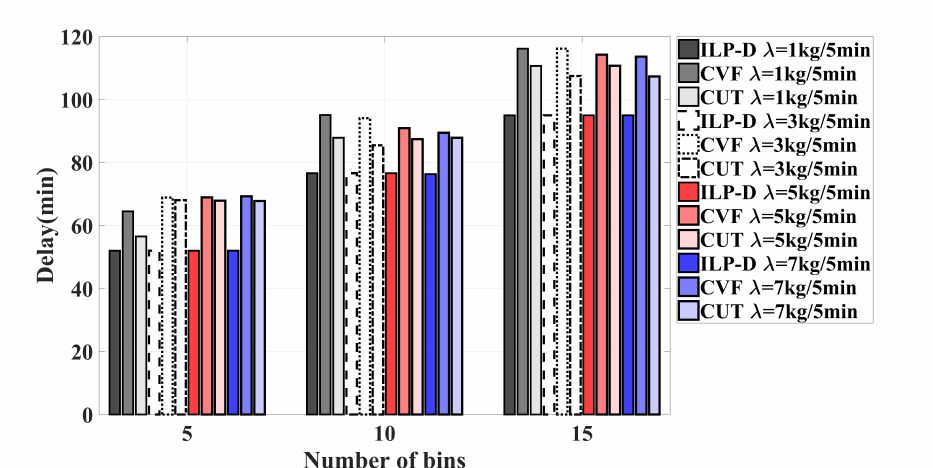
Figure 6. An overview of the system